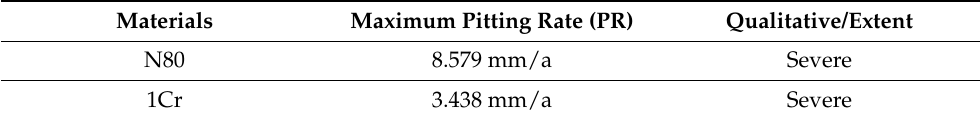
Table 6. Maximum pi tt ing rate and Qualitative of N80 and 1Cr at 50 °C-CO 2 :0.30 MPa. Table 6. Maximum pitting rate and Qualitative of N80 and 1Cr at 50 ◦ C-CO 2 : 0.30 MPa. Materials Materials